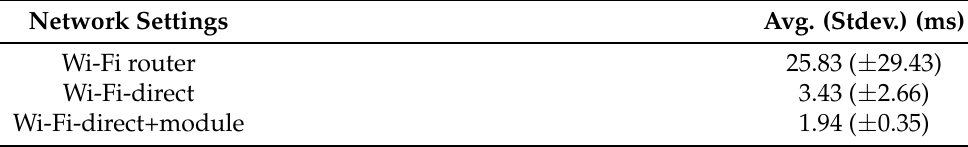
Figure 9. Transformation into global deadline. Table 5. Network latency on different